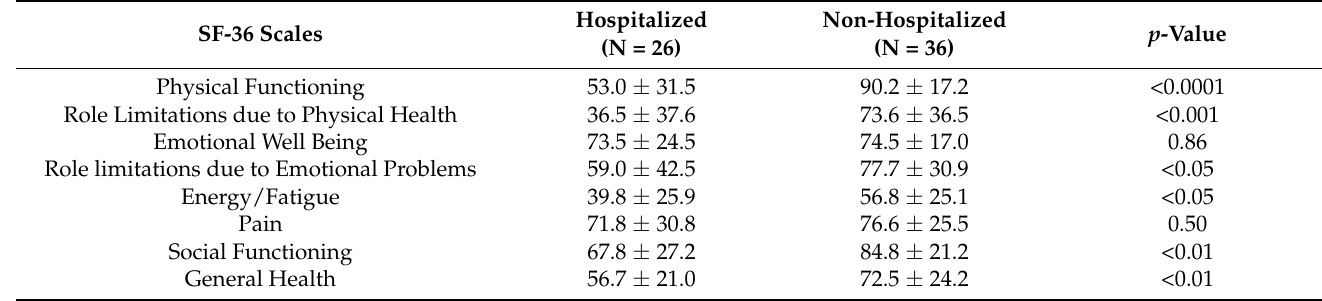
Table 2. Comparison of SF-36 scores in adults hospitalized for COVID-19.